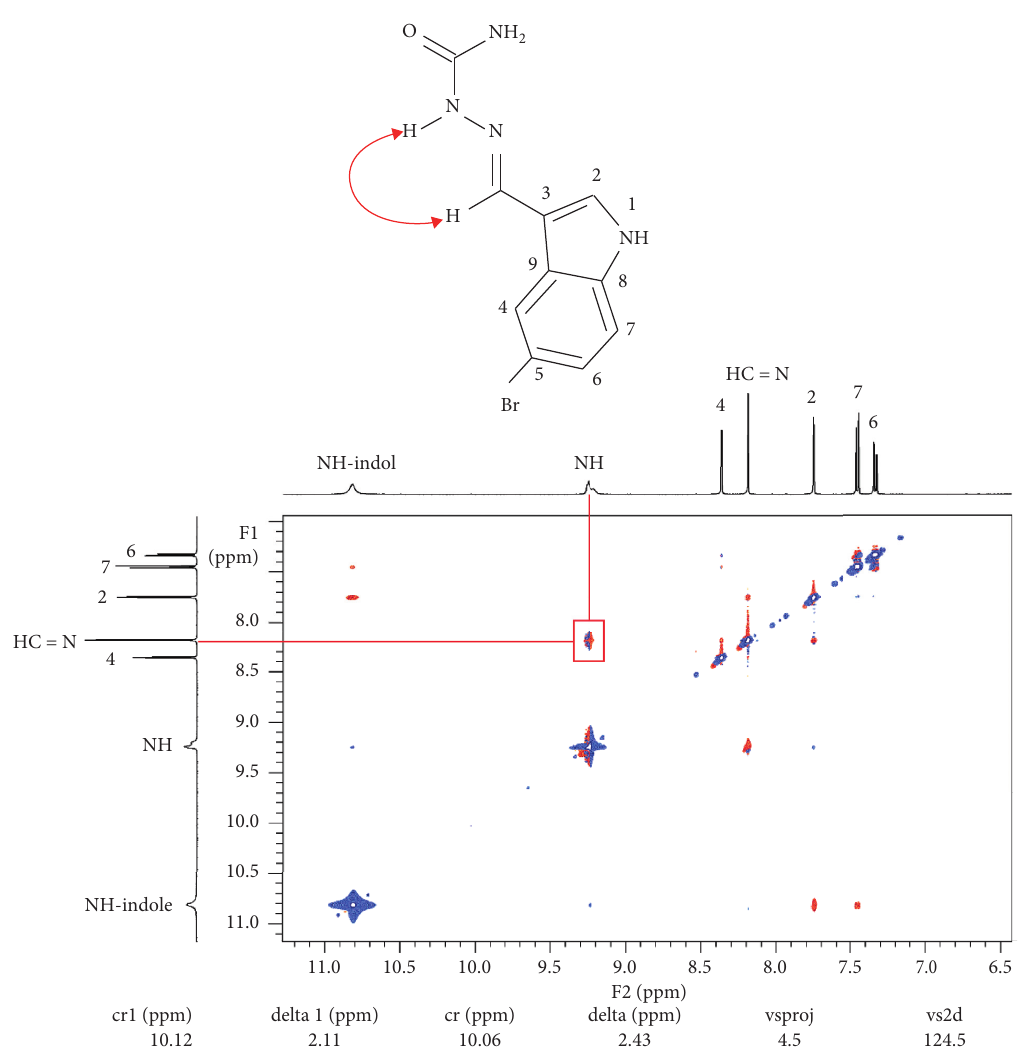
Figure 1: Two-dimensional 1 H- 1 H NOESY NMR spectrum (500 MHz) recorded in acetone-d